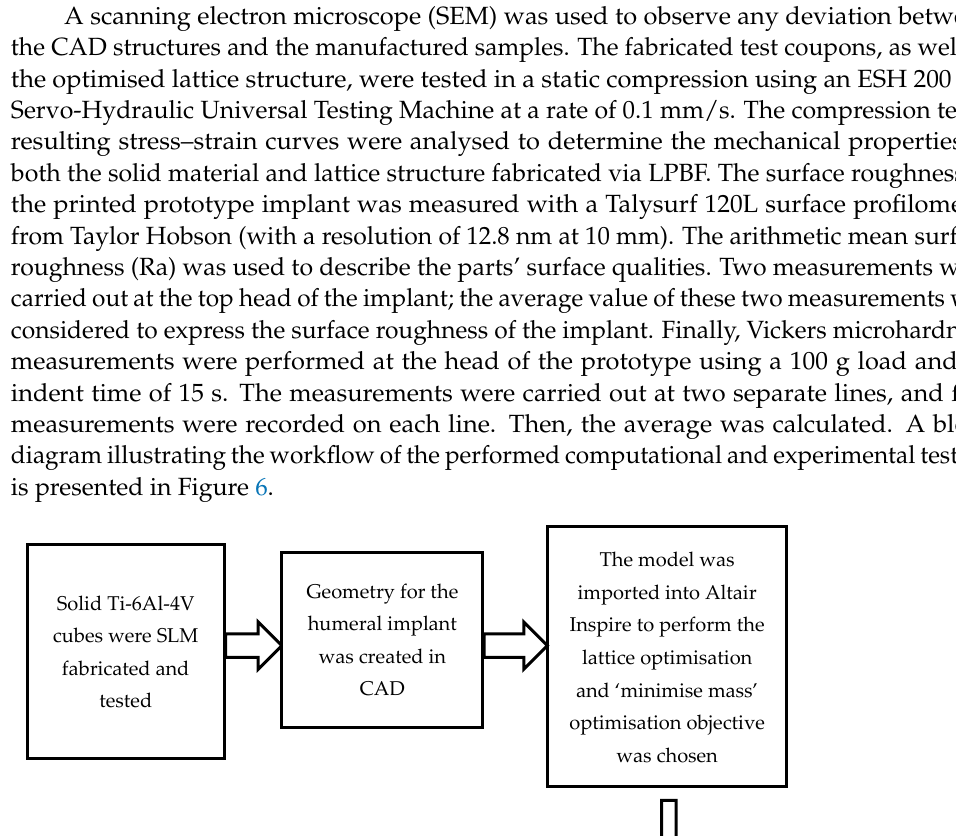
Figure 5. Ti-6Al-4V samples fabricated using LPBF: ( a ) LPBF coupons for compression-testing properties; ( b ) optimised lattice design.